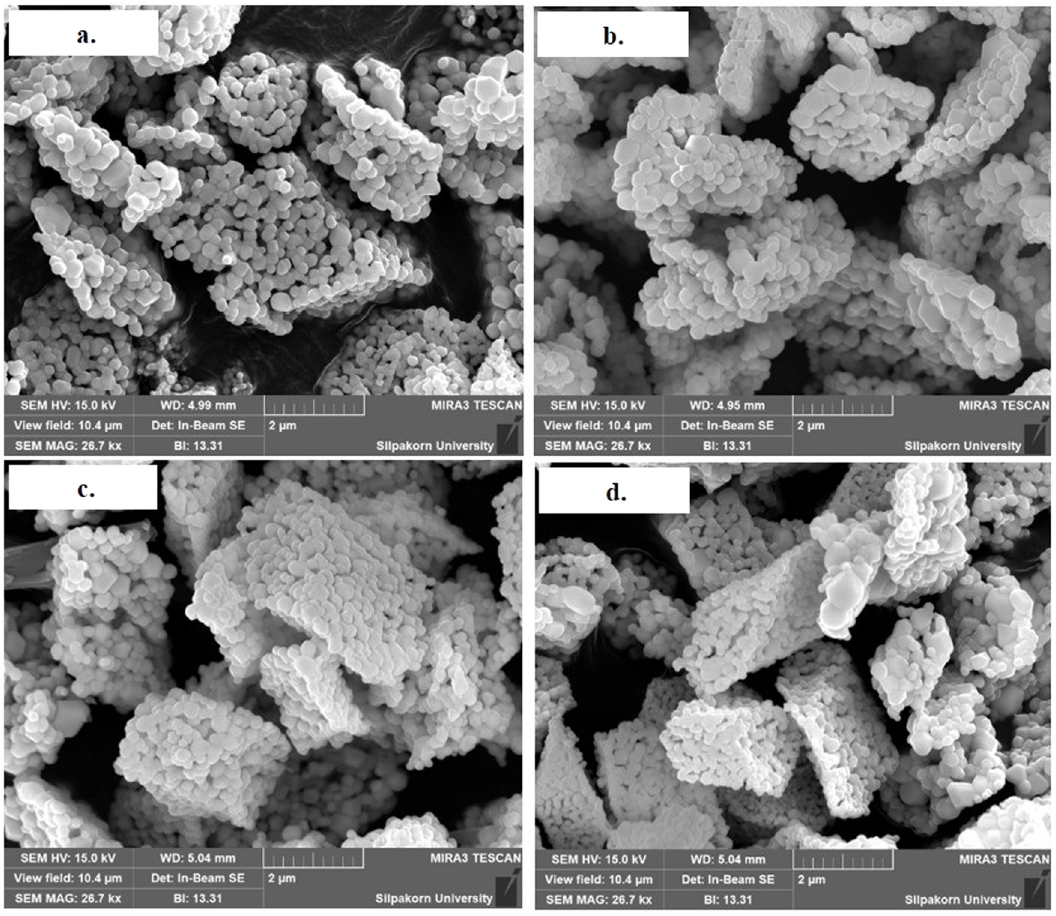
Figure 5: SEM micrograph ( 26,700 × magni fi cation ) of CeO 2 synthesized using di ff erent stirring rates: ( a ) 200 rpm, ( b ) 400 rpm, ( c ) 600 rpm, and ( d ) 800 rpm at 3% oxalic concentration.